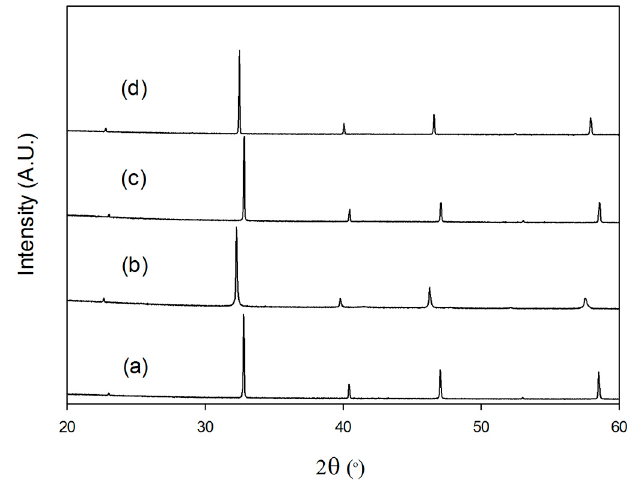
Figure 12. X-ray diffraction patterns for ( a ) SrFe 0.95 B 0.05 O 3- δ , ( b ) SrFe 0.95 B 0.05 O 3- δ after heating under N 2